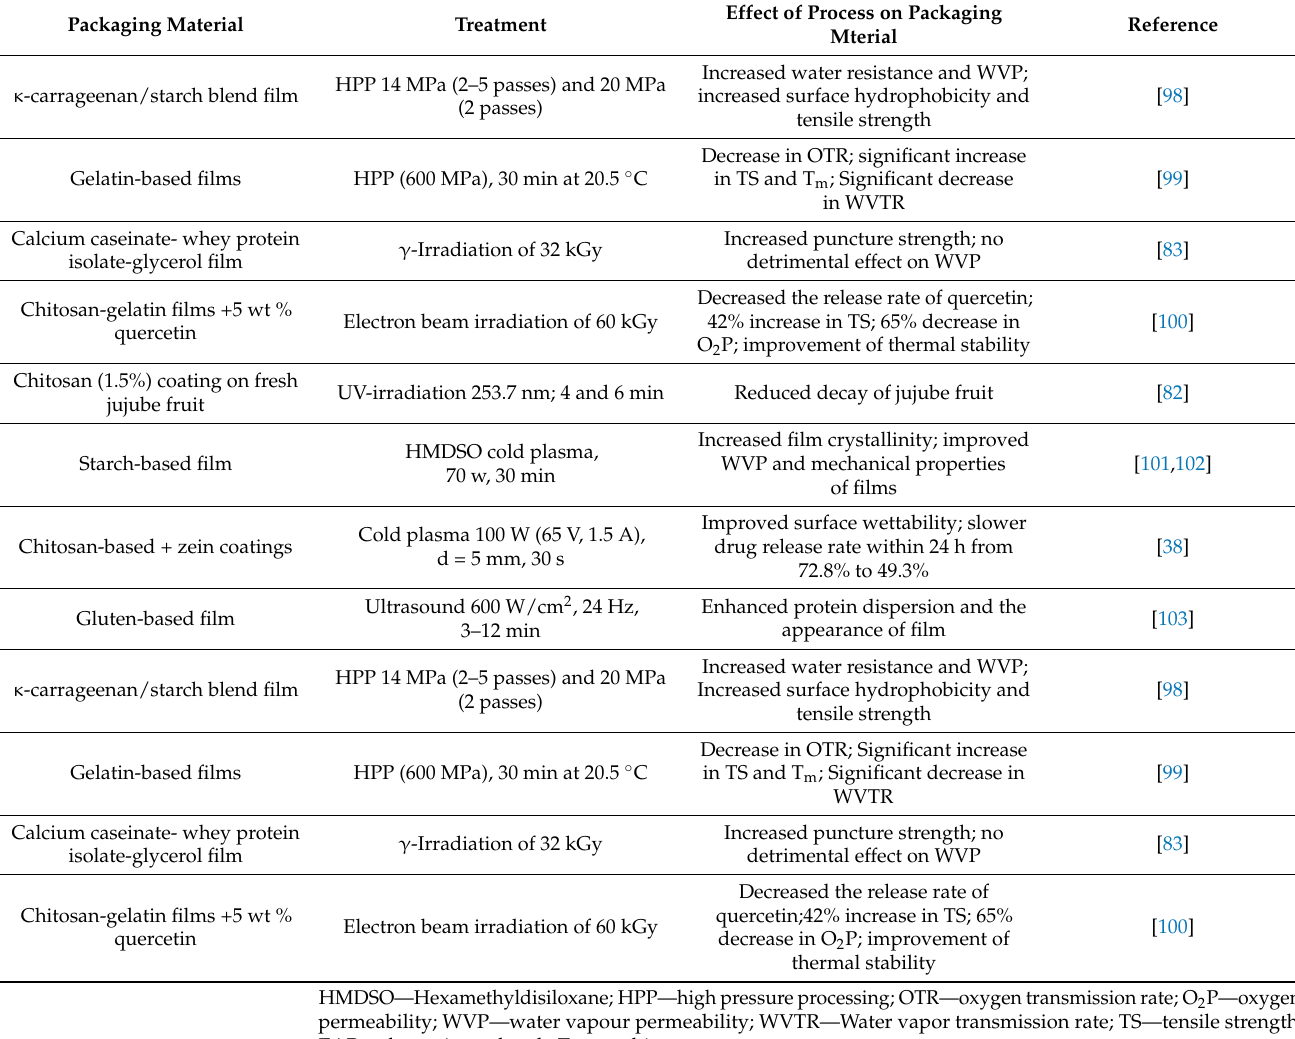
Table 1. Effect of non-thermal treatments on characteristics of edible packaging